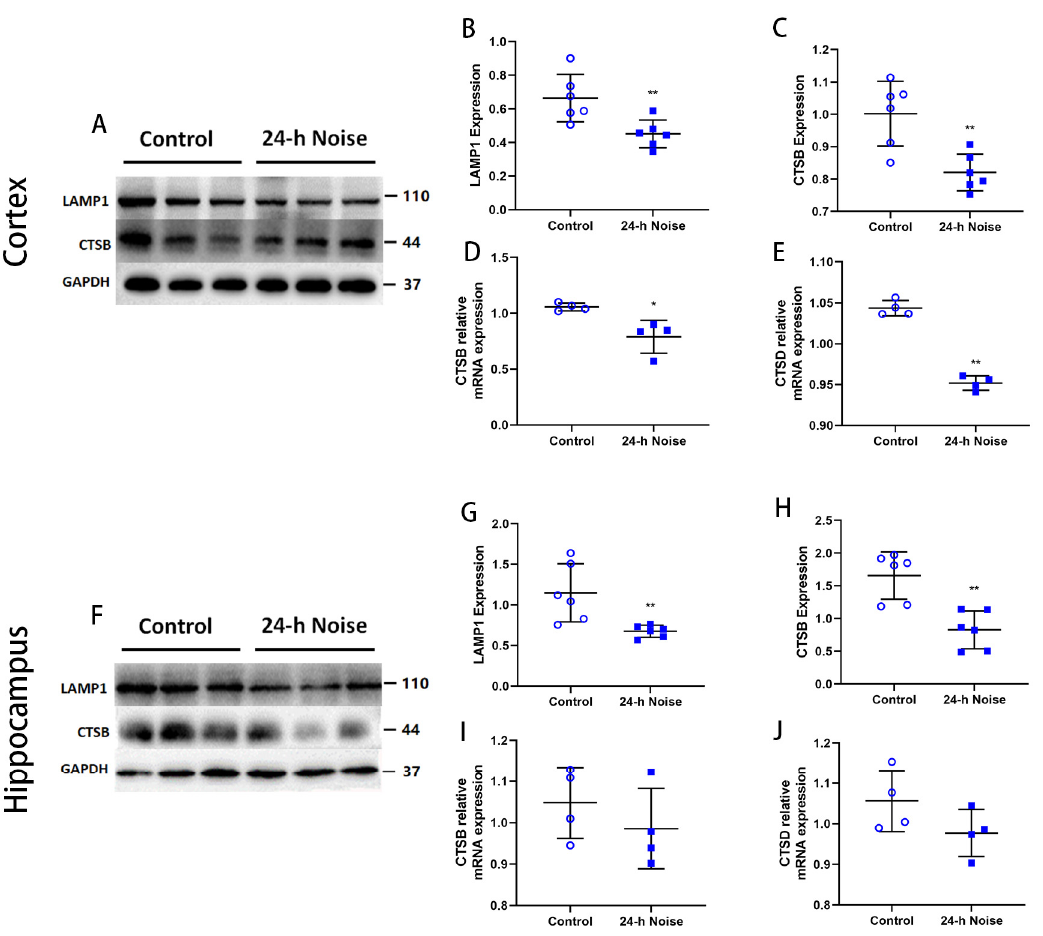
Figure 5. Around-the-clock noise (24 h/day) exposure impairs autophagosome–lysosome fusion and degradation. ( A , F ) Western blot of LAMP1 and CTSB expression in the cortex and hippocampus. ( B , C , G , H ) Quantification data showed that around-the-clock noise (24 h/day) decreases the expression of LAMP1 and CTSB in the cortex and hippocampus ( n = 6 per group). ( D , E , I , J ) The mRNA expression of CTSB and CTSD in the cortex and hippocampus ( n = 4 per group). * p < 0.05, ** p < 0.01.